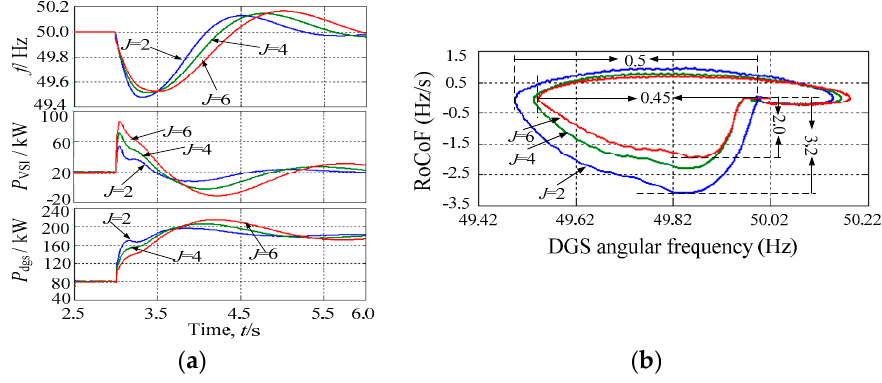
Figure 13. ( a ) Effects of the different values of virtual inertia and zero virtual damping on an active power transient; ( b ) Angular frequency-acceleration curves of DGS with virtual inertia control loop.